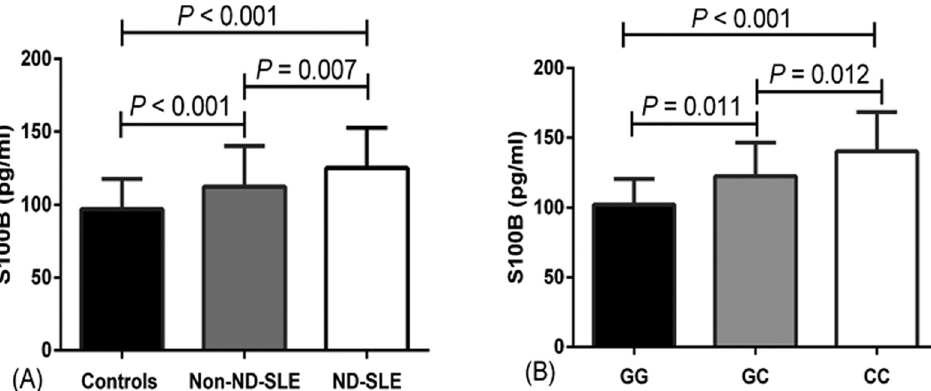
Figure 1 - ELISA detection of S100B levels (A) The SLE patients with neurologic disorder (125.08 (cid:3) 20.34 pg/mL, n=71) showed higher serum S100B levels than non-neurologic disorder patients (112.30 (cid:3) 27.98 pg/mL, n=71) and controls (97.16 (cid:3) 20.34 pg/mL, n=71), respectively [both p < 0.05]. (ND-neurologic disorder). (B) The SLE patients with neurologic disorder carrying the rs1051169 CC genotype (140.29 (cid:3) 28.17 pg/mL, n=24) showed significantly higher serum S100B levels than whose with GC (122.47 (cid:3) 24.11 pg/mL, n=35) and GG genotype (102.24 (cid:3) 18.26 pg/mL, n=12), respec- tively (both p <